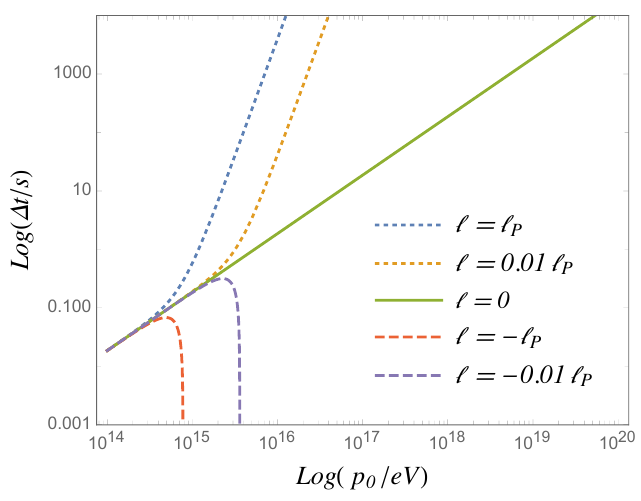
Figure 1 . Lifetime of pion π ± ( m = 140 MeV), according to equation (2.8) following γ DSR